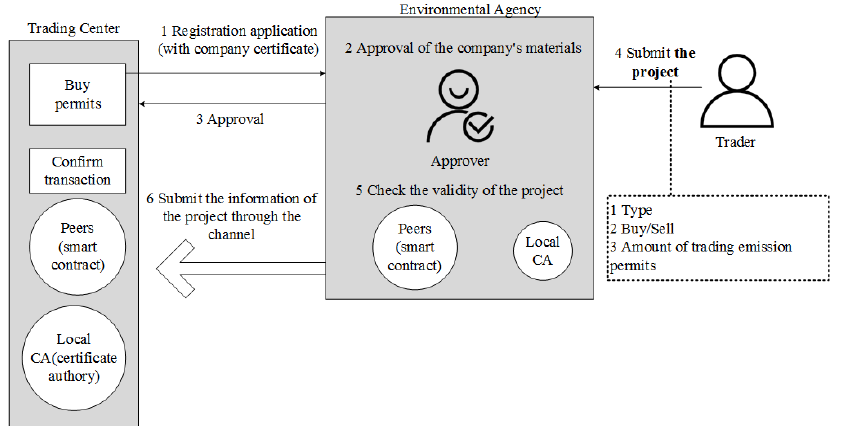
Figure 48. Reconstruction diagram of reference [82].